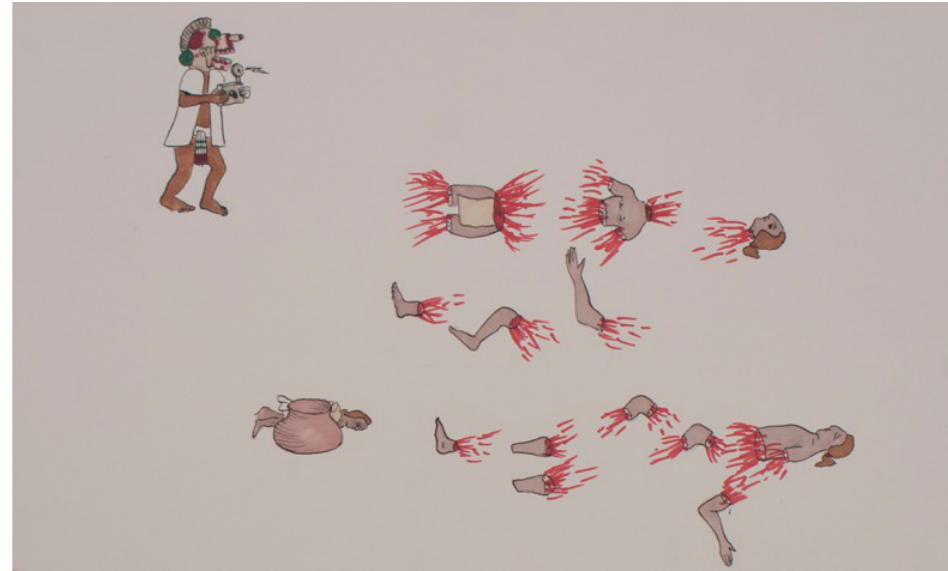
Gabriel Garcilazo, Dystopic Magical Codex: Codex 17 (Collateral Damage) , 2015. Charcoal and ink